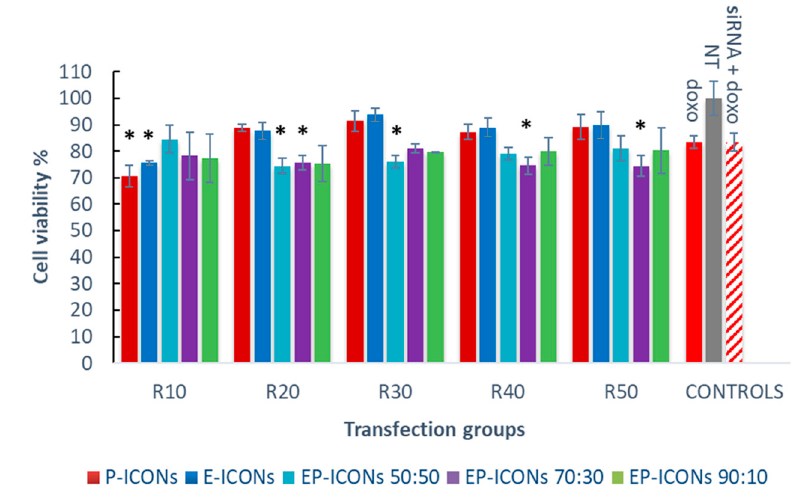
Figure 8. Chemosensitisation experiments. Effects on cell viability of Doxo (24 h) on MCF-7 cells after 24 h pre-treatment with E-ICONs, P-ICONs or EP-ICONs containing siSUR. * represents p < 0.05 with respect to cells treated with naked siSUR and Doxo (siRNA + Doxo).